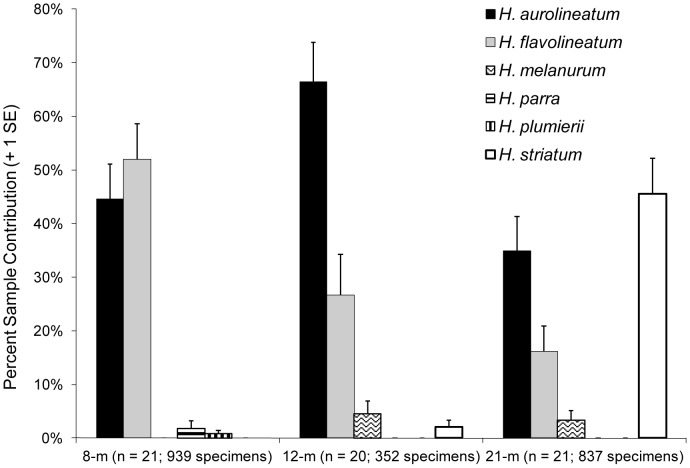
Mean percent sample contribution for newly settled stages of each Haemulon species.Data pooled for experimental trials and treatments.